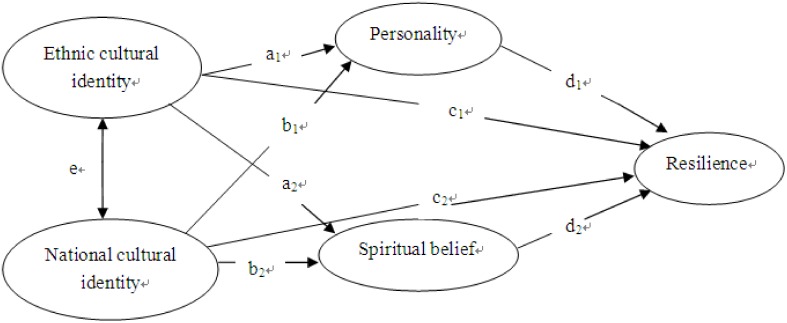
The conceptual model of resilience.